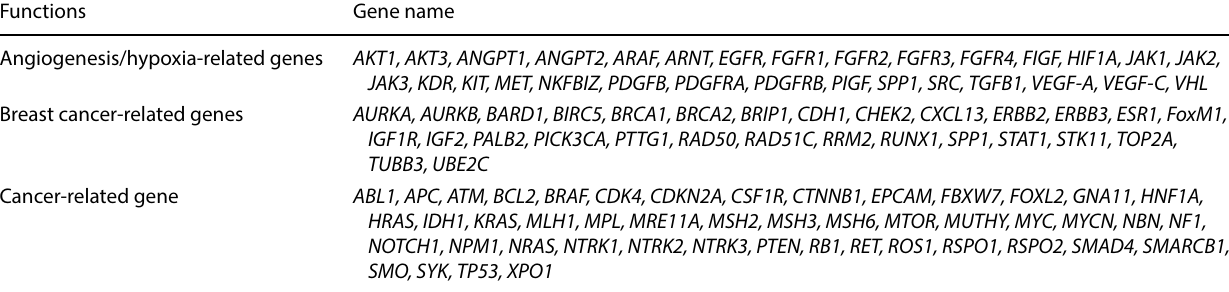
Table 1 Composition of customized targeted gene